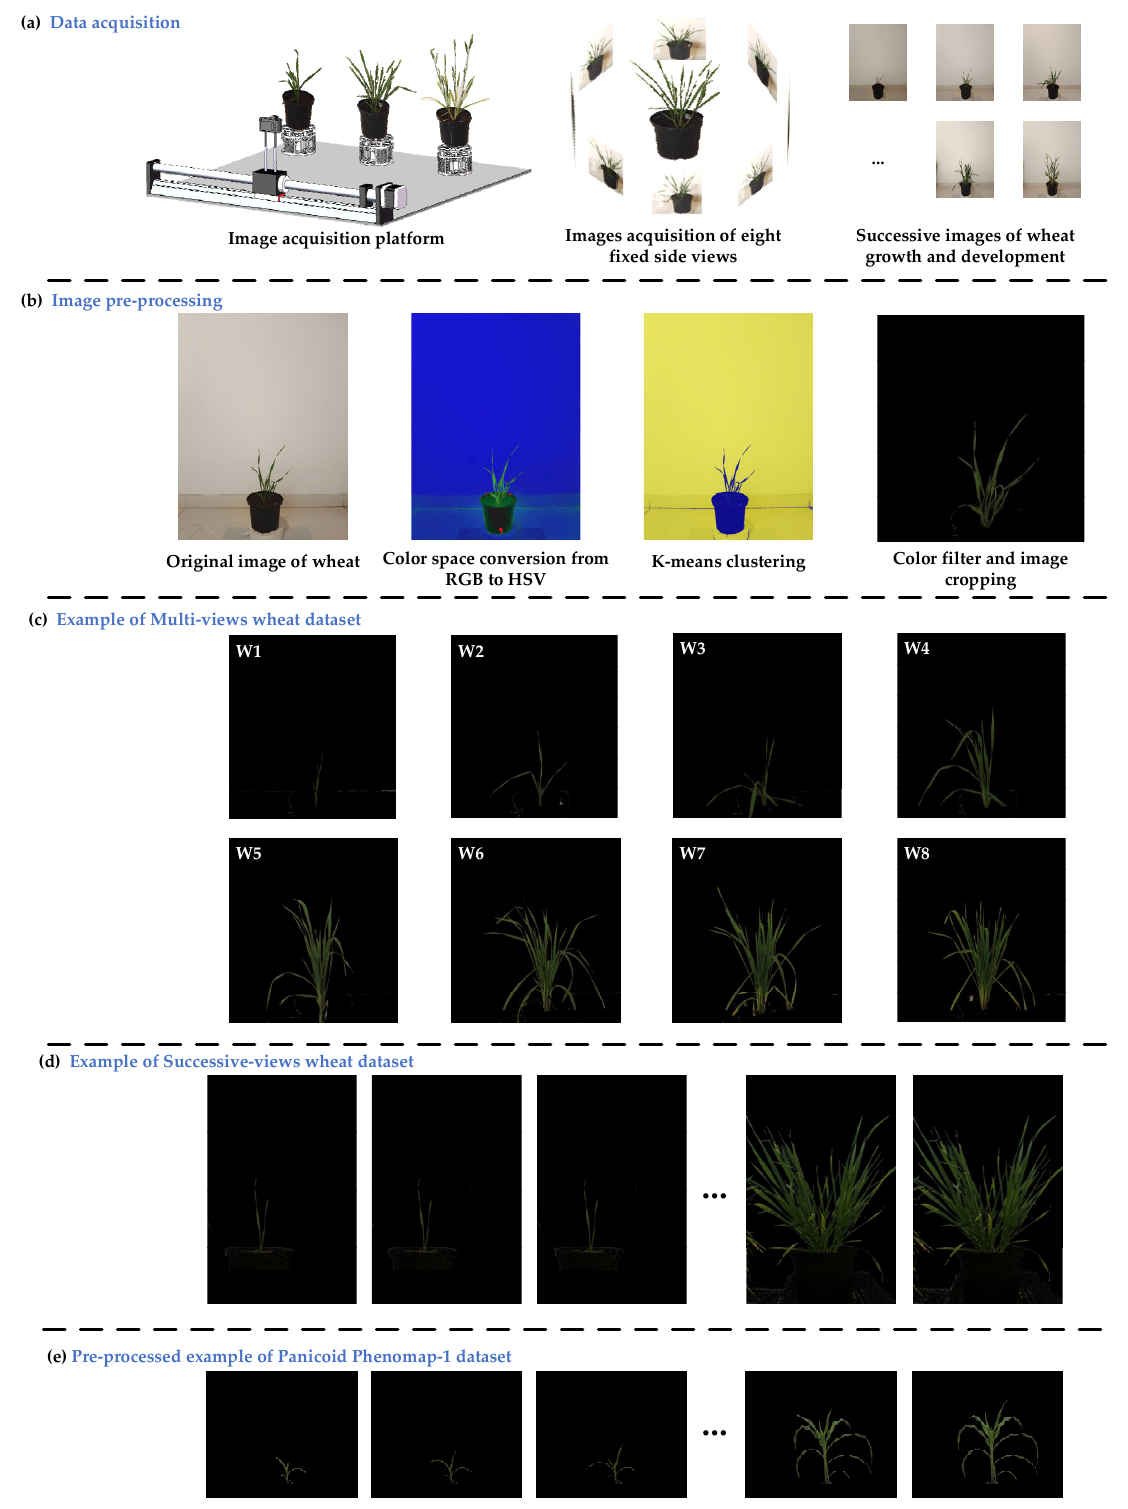
Figure 1. Flowchart of dataset construction and examples of the given dataset content. ( a ) Data acquisition using an image acquisition platform we designed and installed at the growth chamber. ( b ) Image pre-processing to obtain plant images without background. ( c ) Examples of the multi-view wheat dataset content. ( d ) Examples of the successive-view wheat dataset content. ( e ) Pre-processed examples of the Panicoid Phenomap-1 dataset